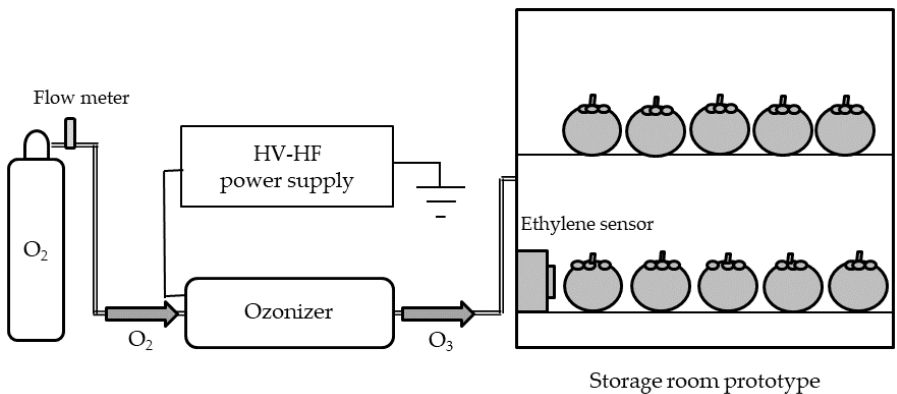
Figure 2. Schematic diagram of the experimental setup used for ozone